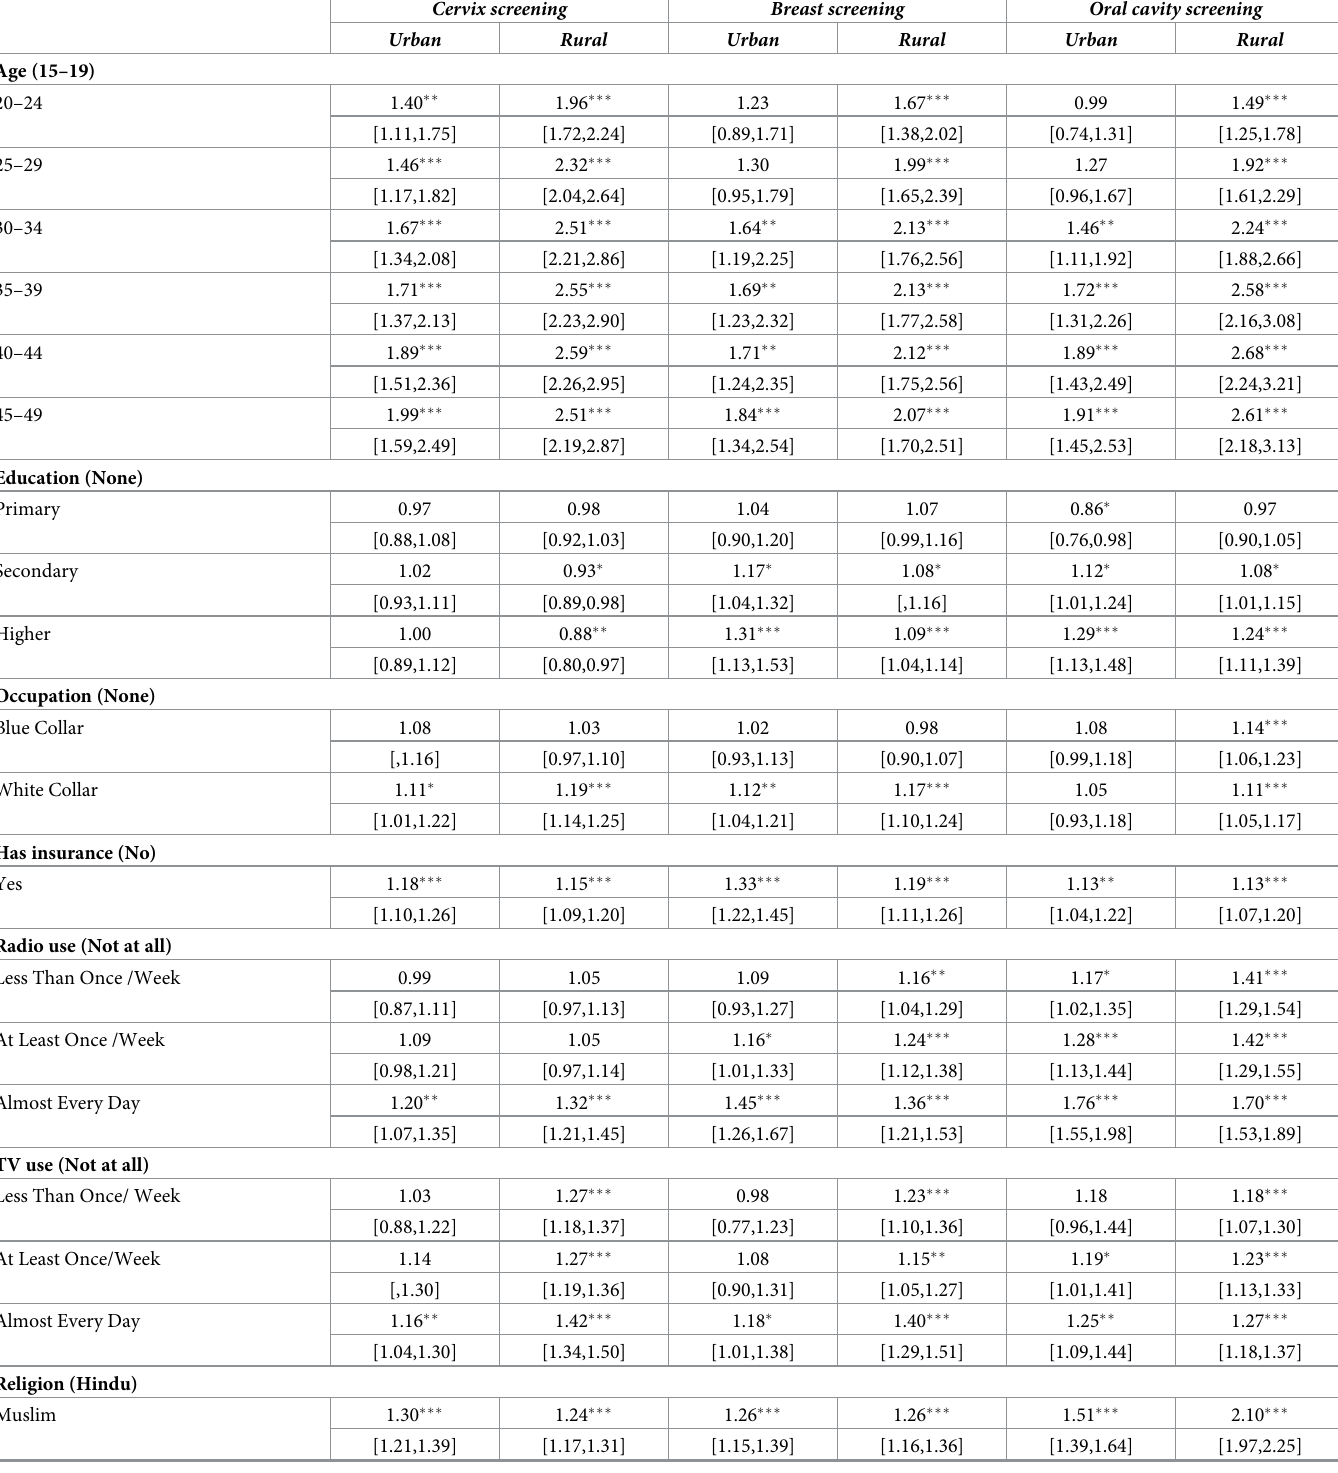
Table 4. Urban-rural differences in the factors associated with cervix, breast and oral cavity screening among Indian